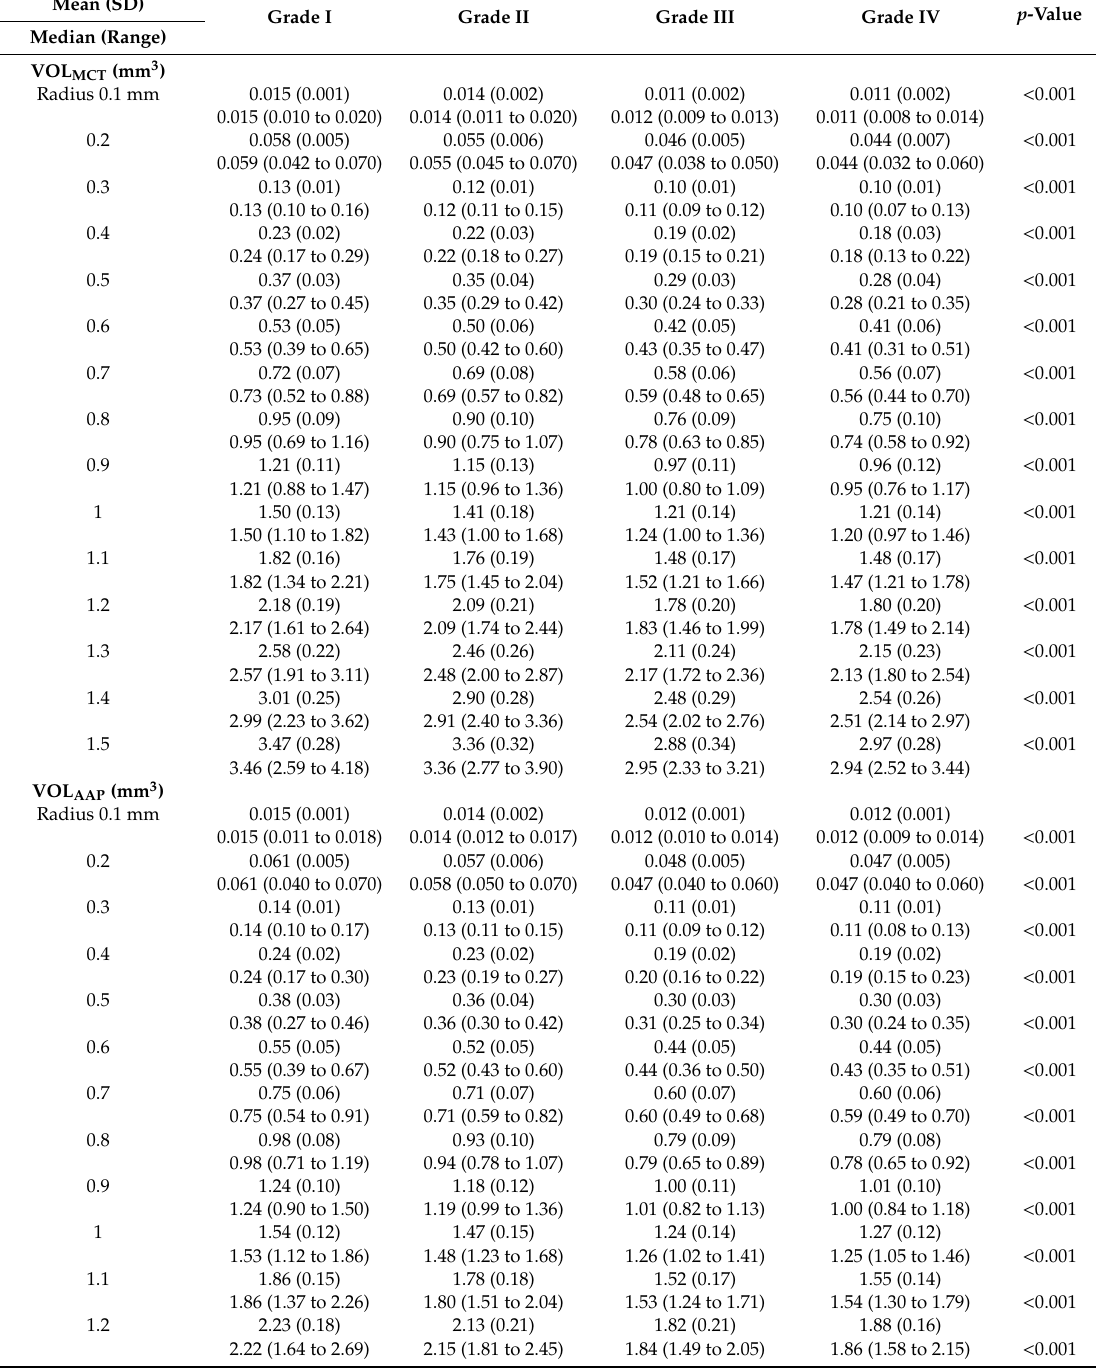
Table 3. Summary of the volumetric data obtained in the evaluated sample according to the level of severity of the disease defined using the RETICS grading system. Abbreviations: SD, standard deviation; VOL MCT , anterior corneal surface area; corneal volume defined by the points of minimal thickness; VOL AAP , corneal volume defined by the anterior corneal apex; VOL PAP , corneal volume defined by the posterior corneal apex. These volumes were calculated for di ff erent radius values of the revolution cylinder, ranging from 0.1 to